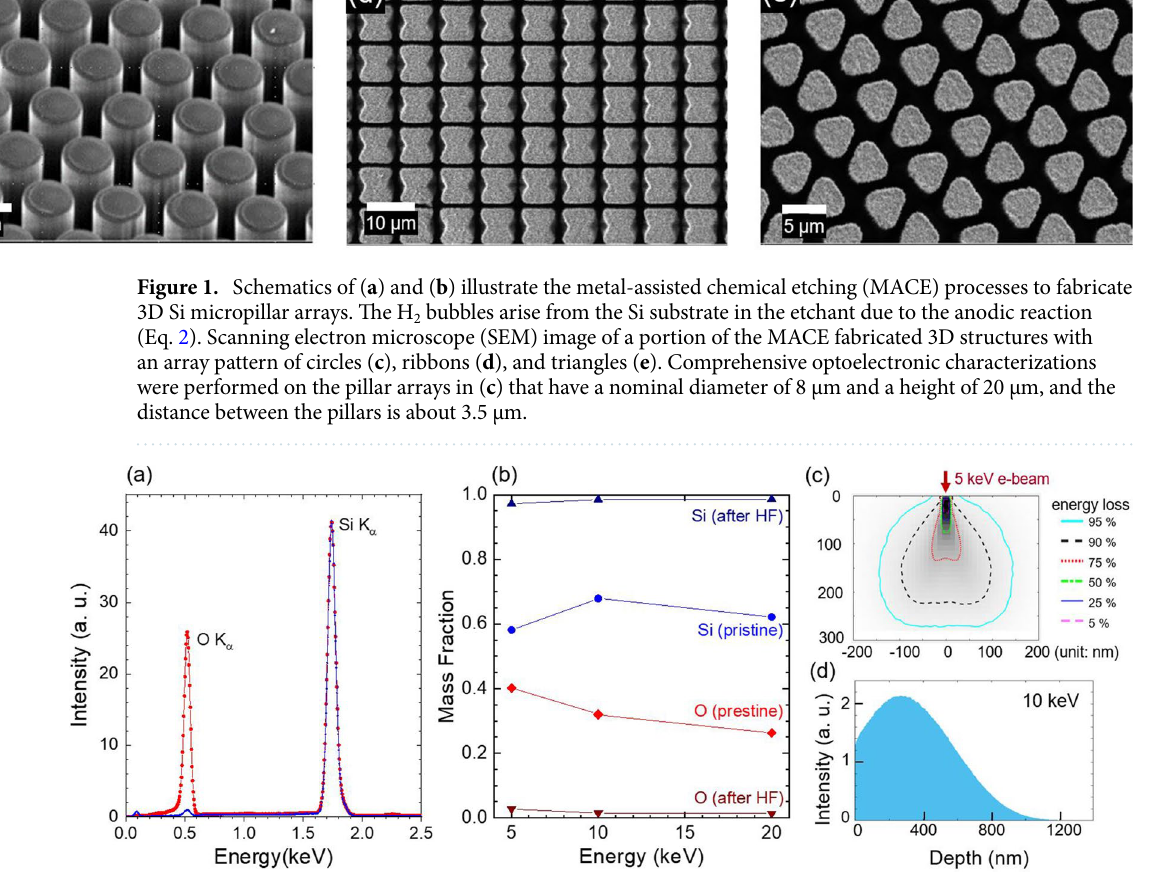
Figure 2. ( a ) Energy-dispersive x-ray spectroscopy (EDS) plots obtained on the Si micropillar arrays before and after removing SiO x in HF. Two prominent x-ray signals at 0.5 keV and 1.7 keV correspond to oxygen (O K α ) and silicon (Si K α ). ( b ) The mass fraction of the pillars after applying a ZAF correction ( Z : atomic number effects, A : absorption, F : fluorescence). Examples of Monte-Carlo simulations showing a full scale of energy loss contours under a 5 keV e-beam irradiation ( c ) and Si K α profile at 10 keV ( d ). An estimated e-beam probe depth by simulations is 220 nm at 5 keV, 800 nm at 10 keV, 1500 nm at 15 keV, and 2700 nm at 20 keV for Si, respectively, where the injected e-beam loses the 90% of initial energy within the corresponding interaction 40 µm × 50 µm) on top of the pillar arrays. Two prominent x-ray signals at 0.5 keV and 1.7 keV are correspond- ing to oxygen (O K α ) and silicon (Si K α ), respectively (Fig. 2a). The integrated intensity ratio of [Si K α ]/[O K α ] increased from 2 to 40 after the HF treatment, indicating a significant amount of oxide was present on the pillar surface after MACE processing. The residual amount of oxygen in the HF treated pillar array is likely attributed to a native oxide formed in air ambient. We collected a series of EDS spectra at different acceleration beam voltages ( V acc ) to obtain a depth-depend- ent compositional profile. Since an e-beam travels deeper into the sample at a higher V acc , the keV-dependent EDS can provide qualitative chemical information from surface to bulk interior of Si micropillar arrays. Using